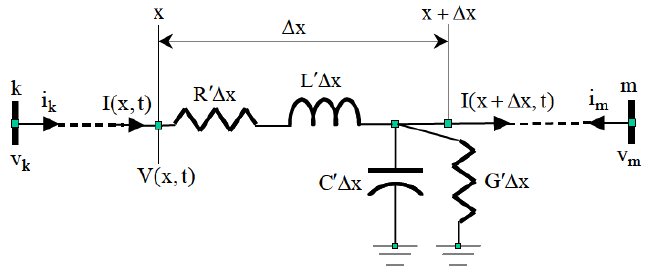
Figure 4. Distributed parameter line